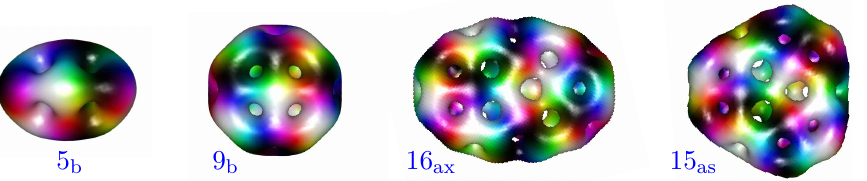
Figure 8. Layered Skyrmions with tetravalent